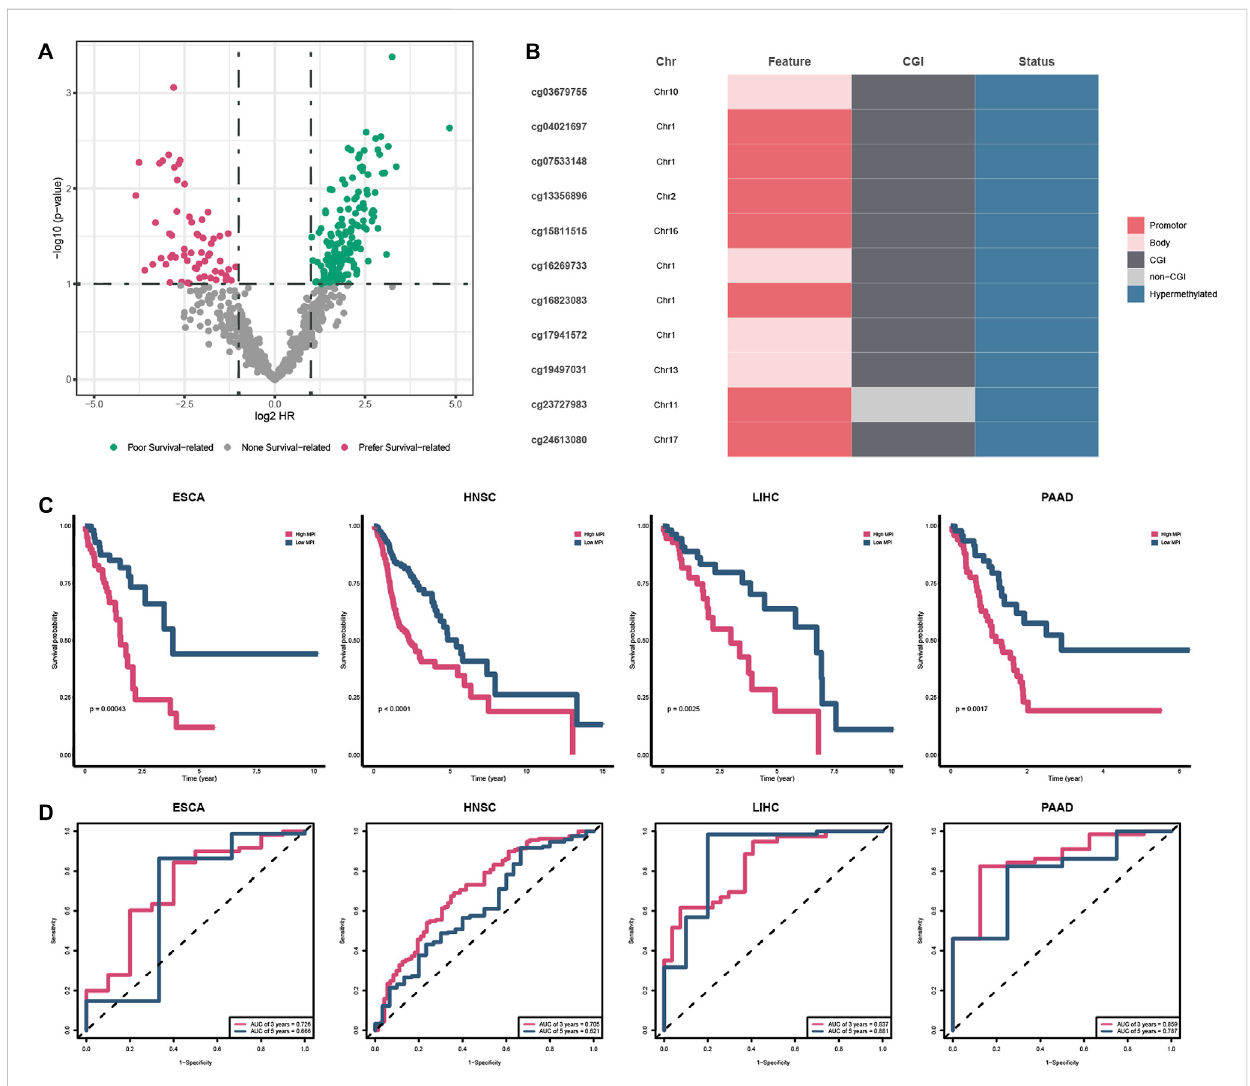
FIGURE 8 SurvivalanalysisofPDMPs. (A) Volcanoplotshowingthesurvival-relatedPDMPsineachcancer. (B) .Characteristicsof11survival-relatedPDMPs. (C) Kaplan – Meier analysis of high- and low-MPI group patients in each cancer type. (D) . ROC curve validating the predictive ability of